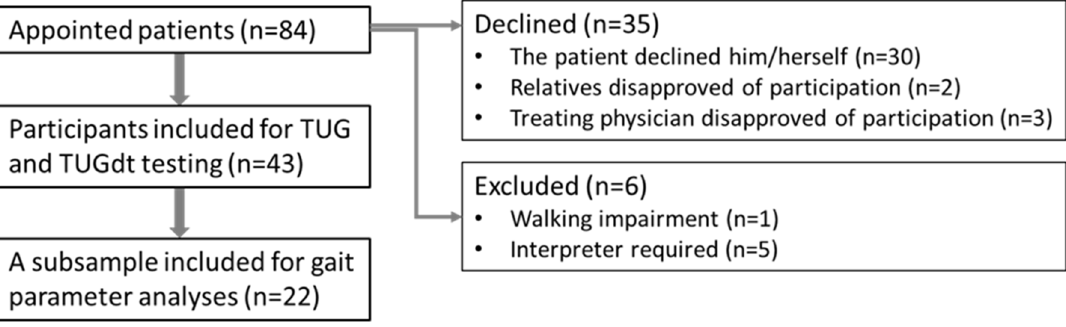
Table 1. Overview of the total study sample (n = 43) and the sub-sample (n = 22)